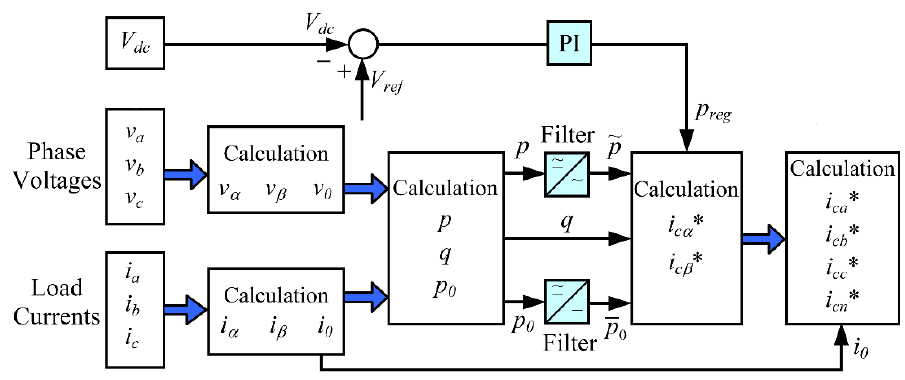
Figure 5. Control block illustration of the p-q theory [27].